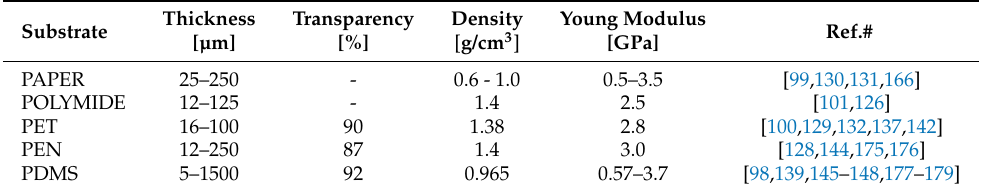
Table 1. Substrates and their physical properties as presented in this review article.